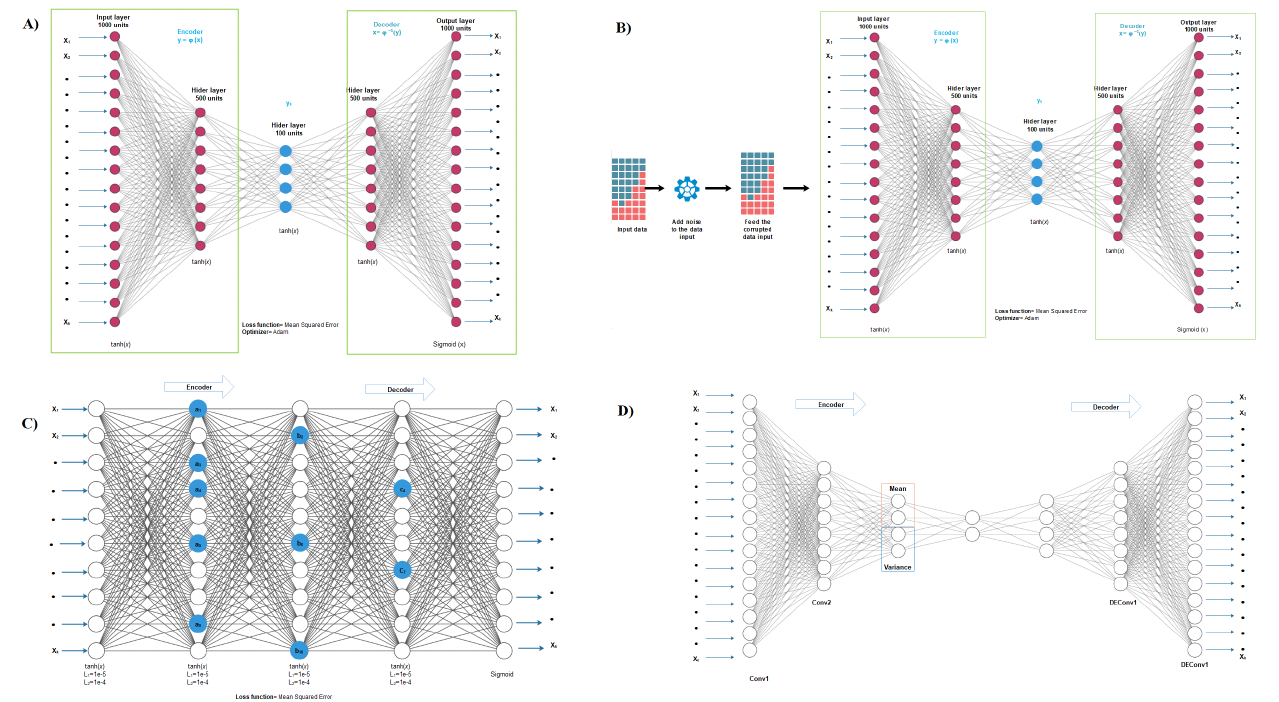
Figure 2. Autoencoder configuration: ( A ) Vanilla autoencoder; ( B ) Denoising autoencoder; ( C ) Sparse autoencoder, and ( D ) Variational